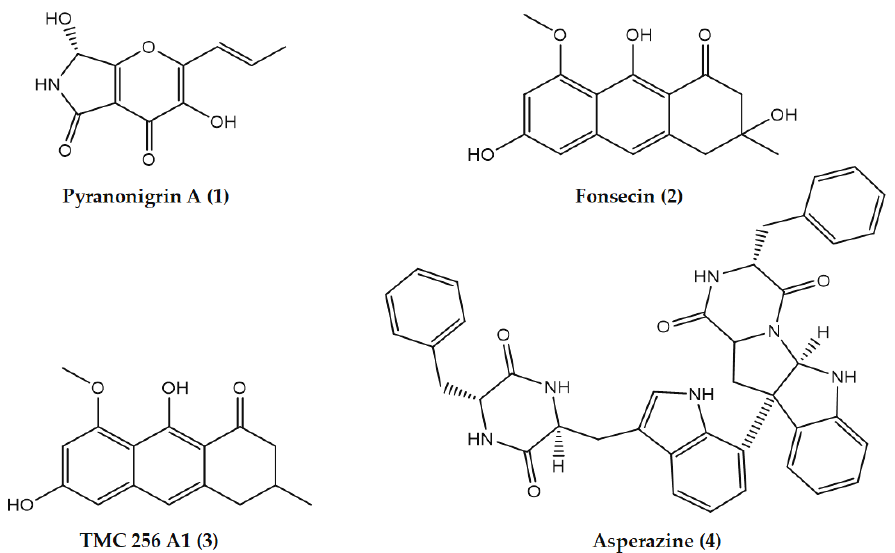
Figure 4. The chemical structures of the isolated pure compounds from the EtOAc extract active fraction of A. tubingensis